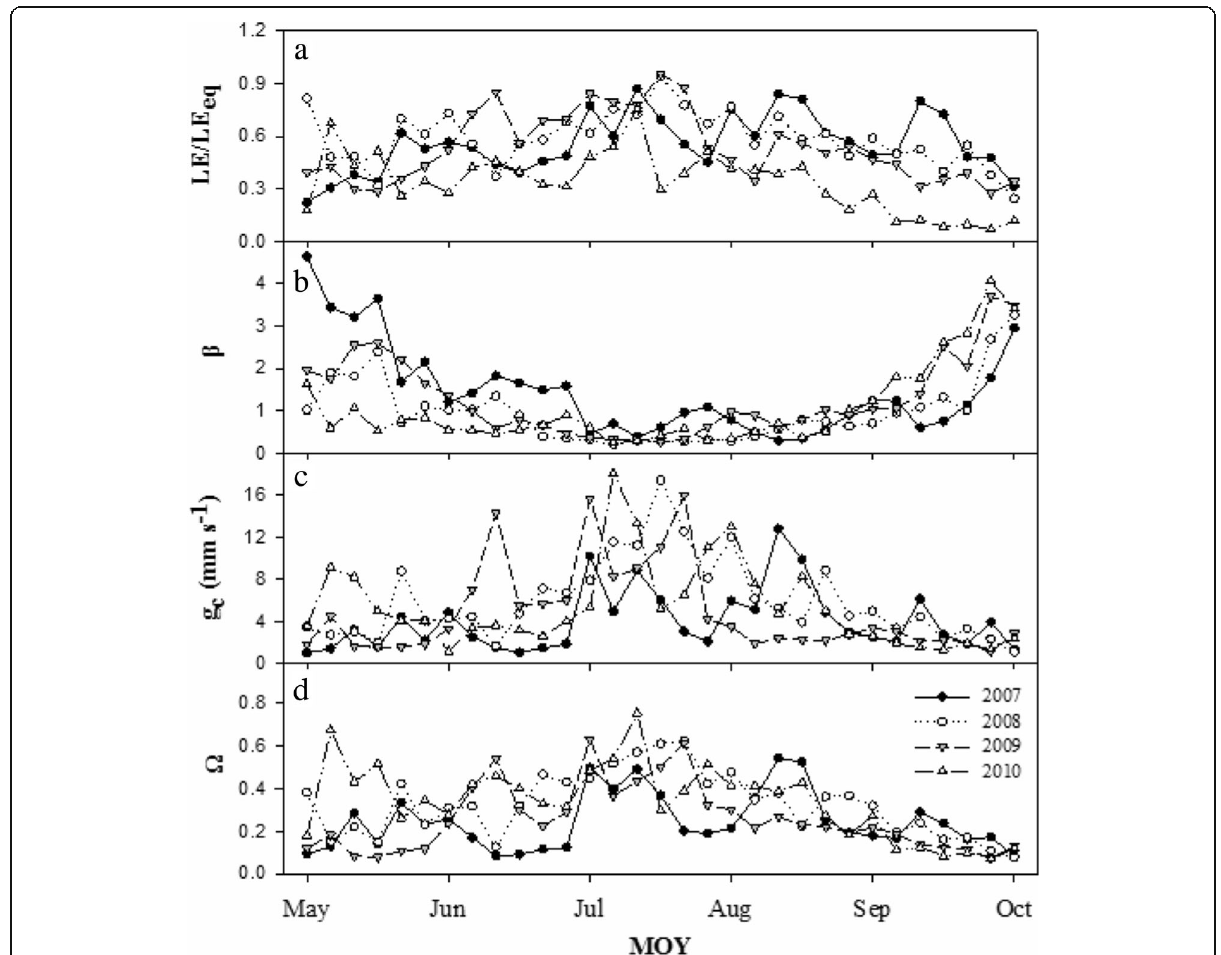
Fig. 6 The seasonal change of 5-day average midday LE/LE eq , Bowen ration ( β ), canopy conductance ( g c ), and decoupling coefficient ( Ω ) in four study years in the meadow steppe. Midday means were calculated for 10:00 – 15:00